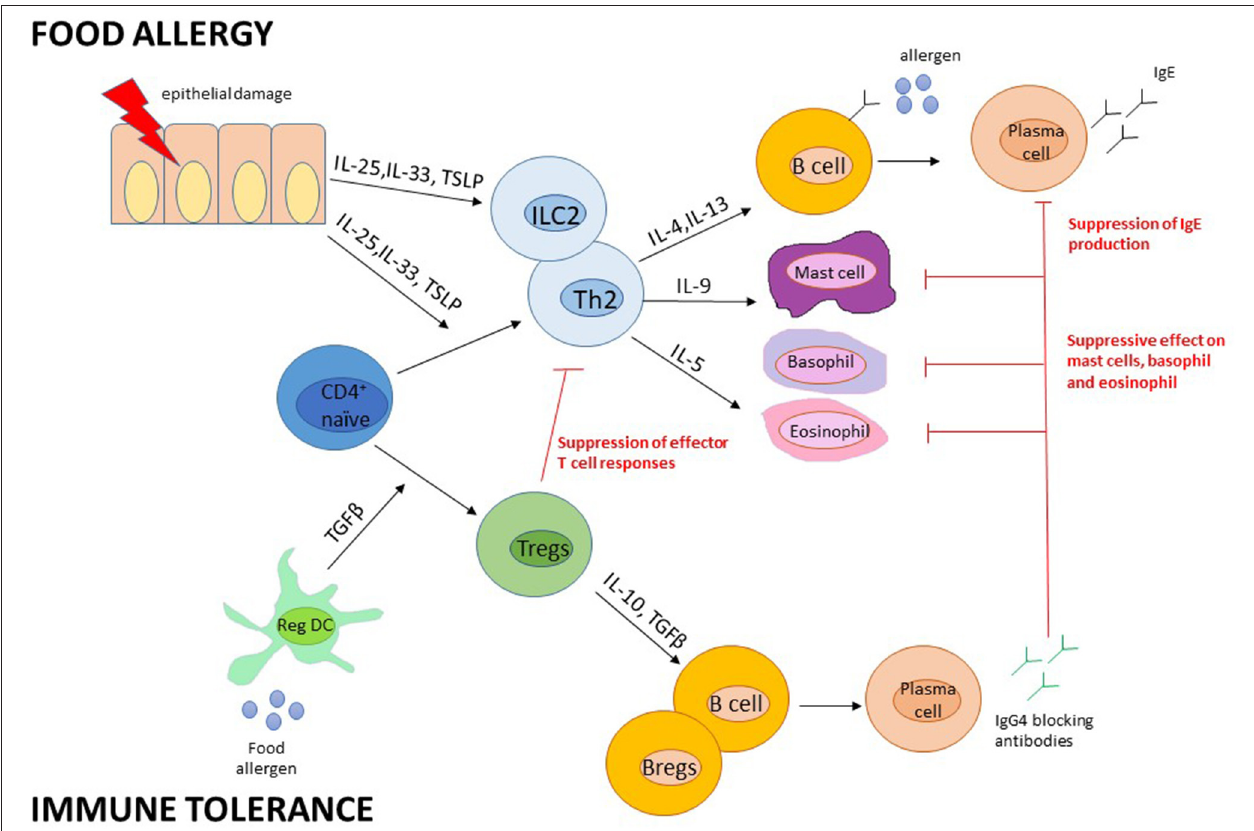
FIGURE 2 | Presumed immune mechanisms in food allergy and immune tolerance. Adapted from Pajno et al. (43). B regs, B regulatory cells; DC, dendritic cells; Ig, Immunoglobulin; IL, interleukin; ILC, Innate Lymphoid cells; T regs, T regulatory cells; TSLP, thymic stromal